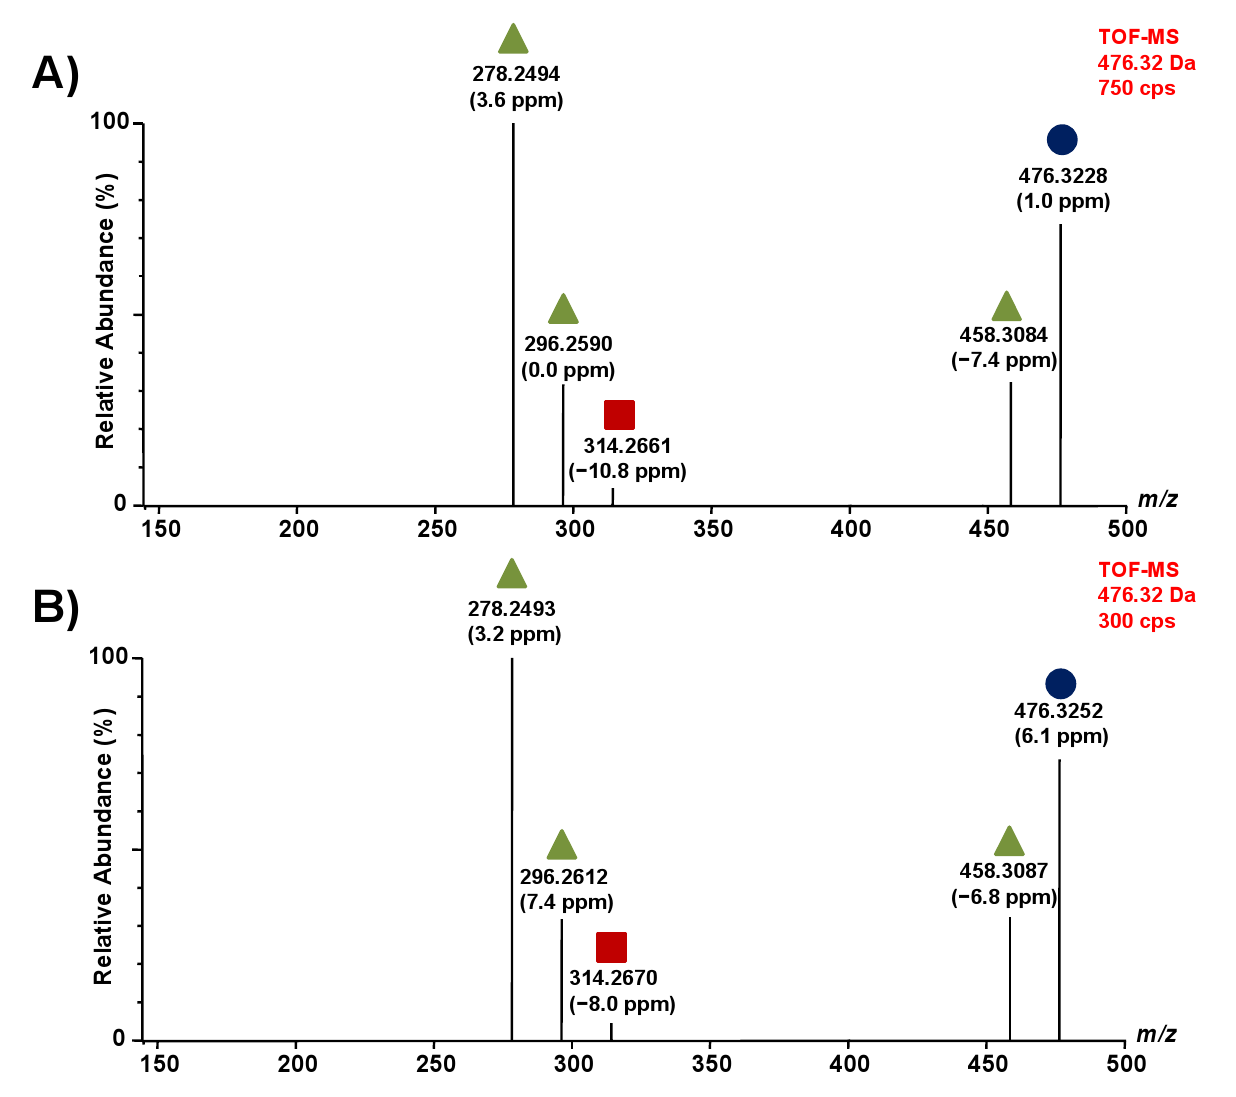
Figure 5. Fragmentation of lyso-Gb 1 analogs +14 Da: ( A ) fragments obtained from the metabolite with a retention time of 5.30 min; ( B ) fragments obtained from the metabolite with a retention time of 5.53 min; in both ( A , B ), the precursor ion is indicated by a purple circle, a green triangle shows a loss of a water molecule, and a red square indicates a loss of a sugar unit. Parts per million (ppm) refers to the difference between experimentally measured masses (accurate mass) and theoretical masses (exact mass). CPS refers to the number of counts per second.